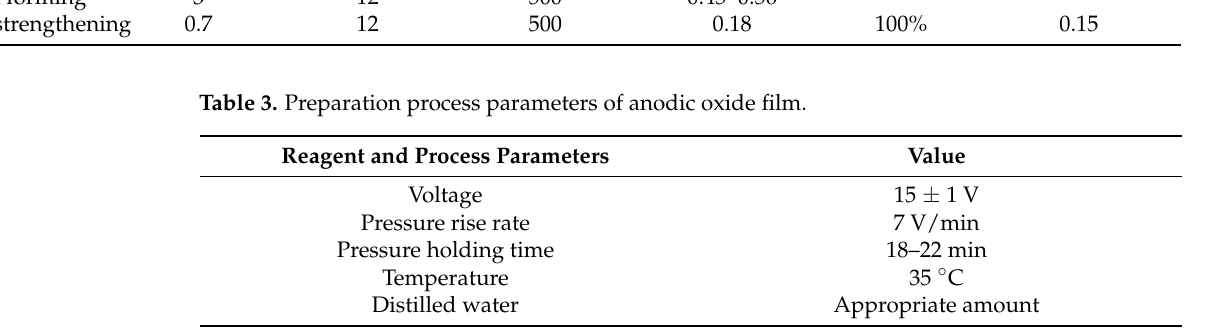
Table 2. Process parameters of shot-peen forming and shot-peen strengthening. Table 3. Preparation process parameters of anodic oxide film.